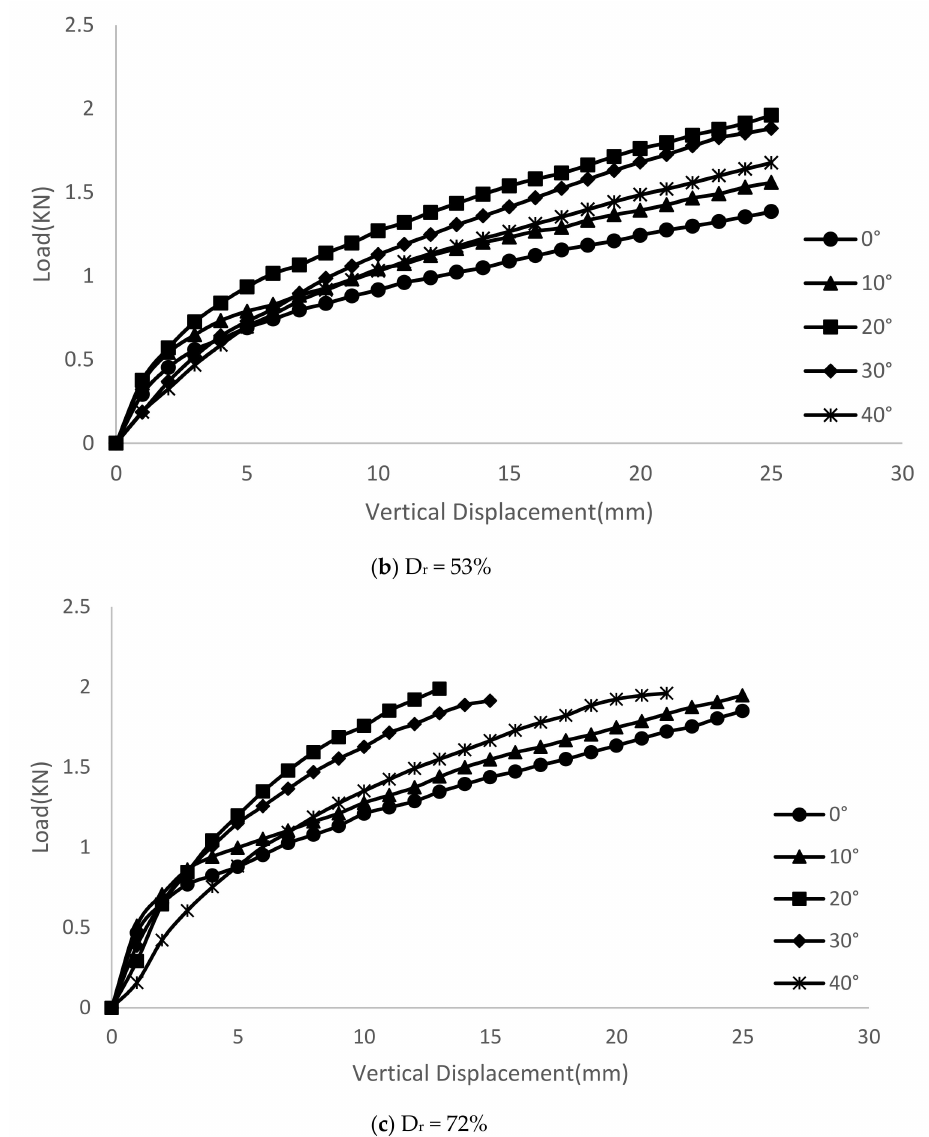
Figure 6. Relation of vertical load and pile head vertical displacement due to the Batter angle.